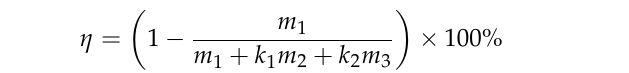
Figure 24. Relation between inhale pressure and the air velocity.